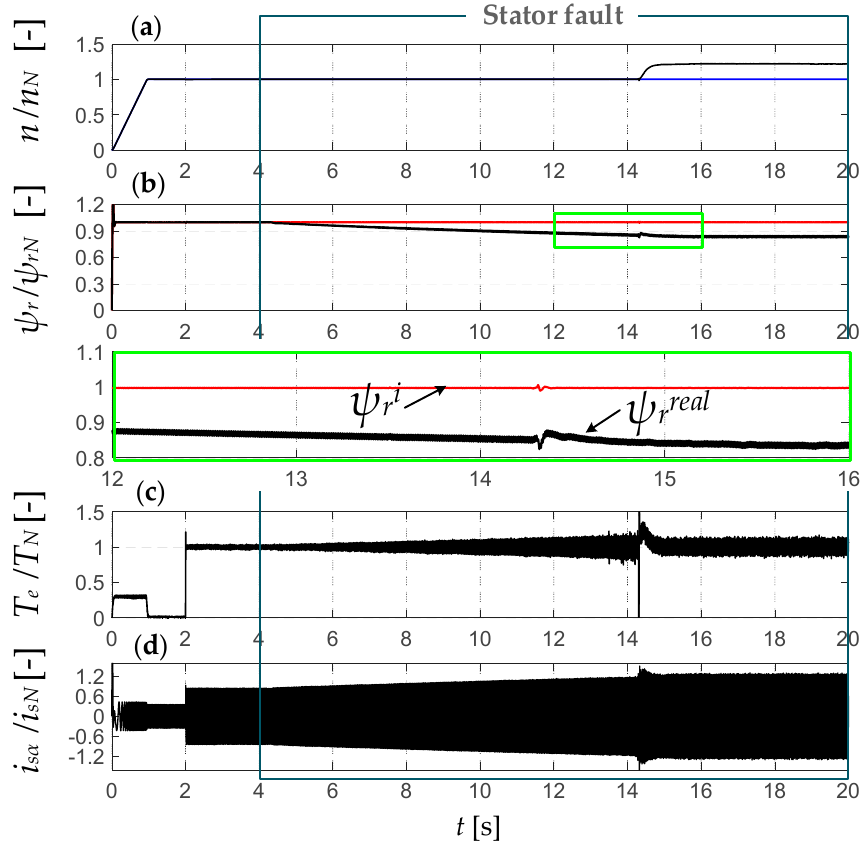
Figure 7. Operation of closed-loop control scheme (DFOC) during ITSC with the CM in the control structure: ( a ) reference and real rotor speed, ( b ) estimated and real rotor flux, ( c ) electromagnetic torque, ( d ) stator current in phase A; (simulation results), ( n ref = n N , T l = T N ).